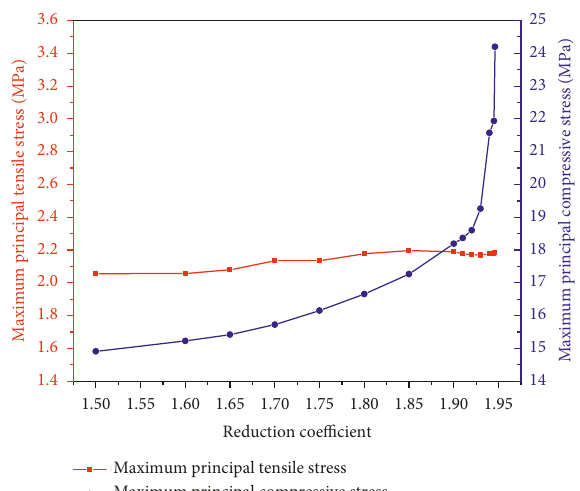
Figure 18: Variation law for the maximum principal stress of the tunnel structure with reduction coefficient.